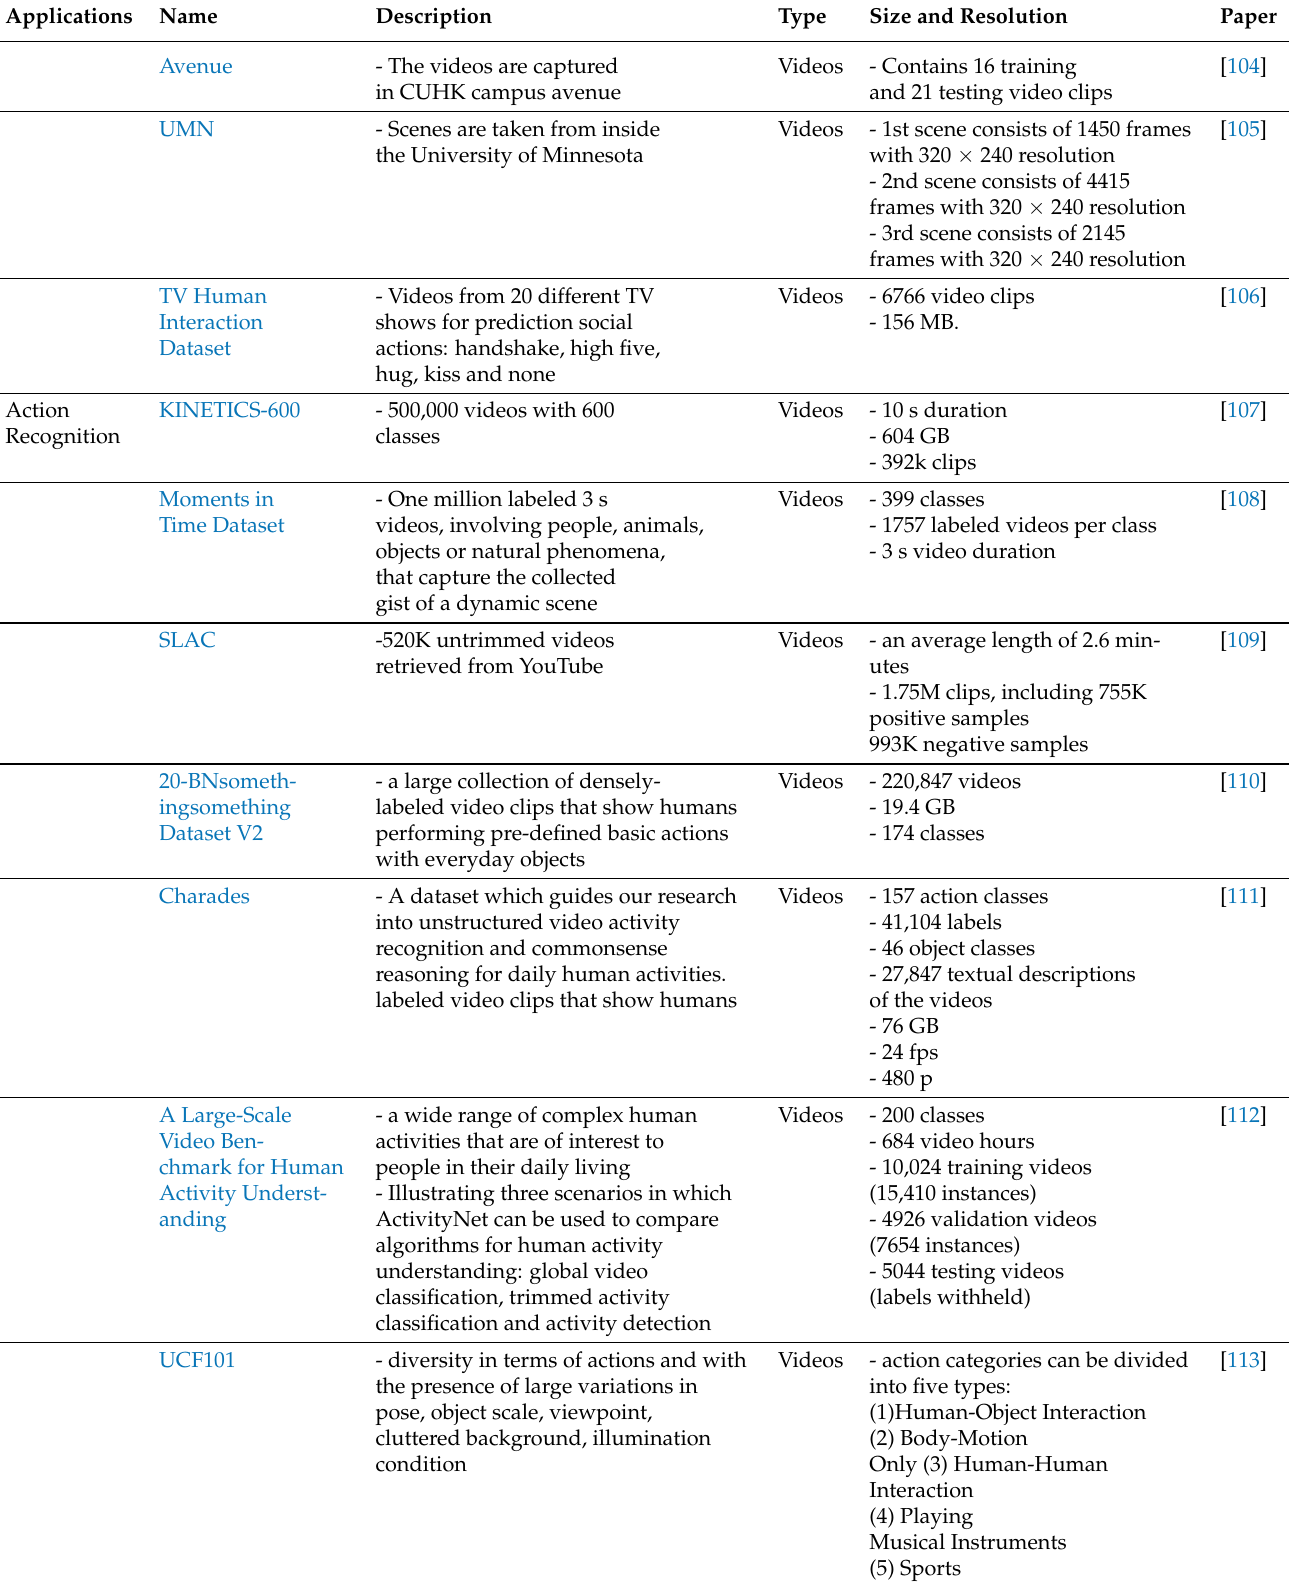
Table 8. Frequently used